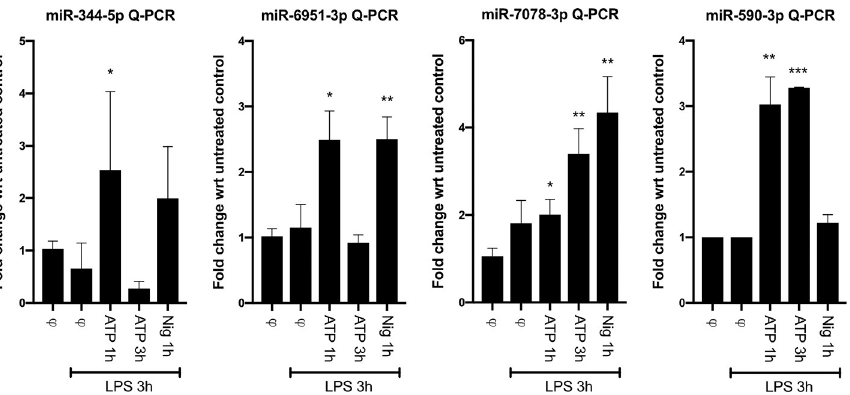
Fig 3. miRNAs predicted to target negative regulators of NLRP3 inflammasome are upregulated following inflammasome activation. Day 6 bone marrow macrophages prepared from WT C57/Bl6 mice were primed with 1 μ g/ml LPS for 3 h (signal 1) before stimulation with NLRP3 inflammasome activators: 5 mM ATP for 1 or 3 hours or 10 μ M nigericin for 1 hour (signal 2). Real-time Q-PCR analysis for the expression of mature miR-590-3p, miR-344, miR-6951-3p and miR-7078-3p was performed. Ubiquitously expressed U6 small nuclear RNA was used as a reference to normalize the data. � p < 0.05; �� p < 0.01; ��� p < 0.001.